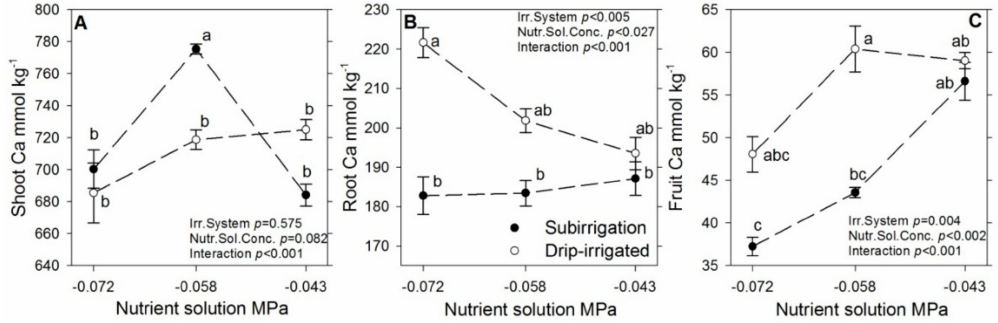
Figure 7. ( A – C ) E ff ect of the irrigation system and the concentration of the nutrient solution on calcium concentration in tomato ( Solanum lycopersicum L.) plants. ANOVA significance for both factors, irrigation system (Irr. System) and nutrient solution concentration (Nutr. Sol. Conc.), and the interaction is shown. Means with the same lower-case letter indicate non-significant di ff erences according to Tukey’s multiple comparison test. Bars represent the standard error of the mean ( n =